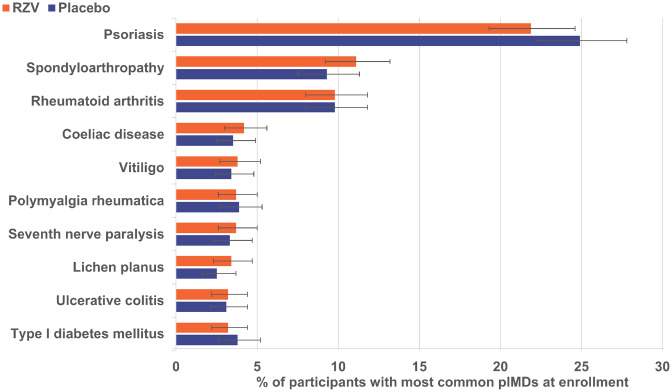
Ten most common pIMDs in both groups at enrolment (TVC)Participants with pre-existing pIMDs were identified by querying the global medical history of the participants included in TVC with a customized Medical Dictionary for Regulatory Activities query for pIMDs [19]. Error bars represent 95% CI. pIMD: potential immune-mediated disease; Placebo: participants receiving placebo; RZV: participants receiving the adjuvanted recombinant zoster vaccine; TVC: total vaccinated cohort.